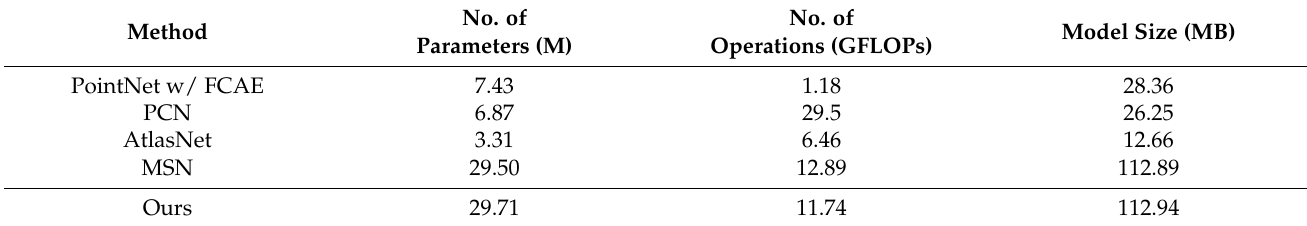
Table 4. Comparison of neural network complexity by number of parameters, number of operations and model